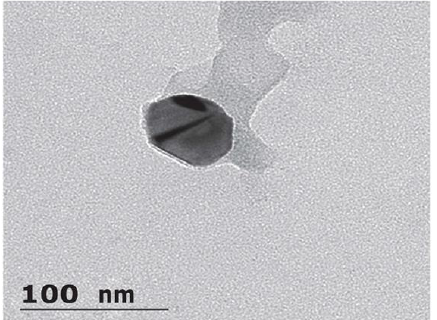
Figure 5. Representation of TEM findings of methotrexate-loaded nanoemulsion.